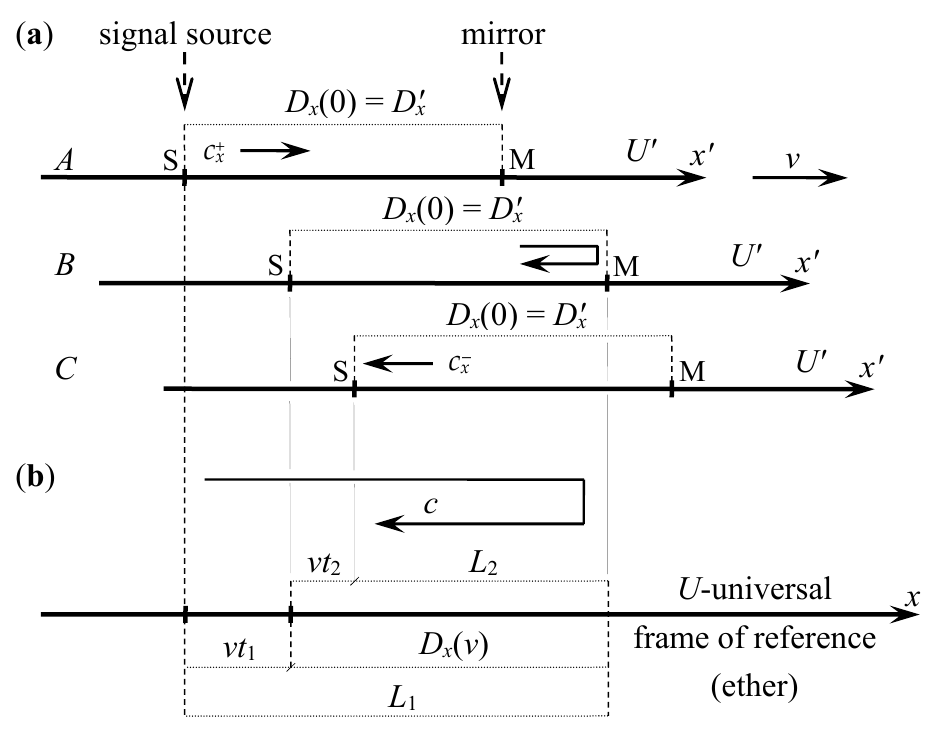
Figure 4. Light clock: ( a ) the path of light impulse seen from U ′ system in which the clock is located; ( b ) the path of light impulse seen from U system in which the light propagates.